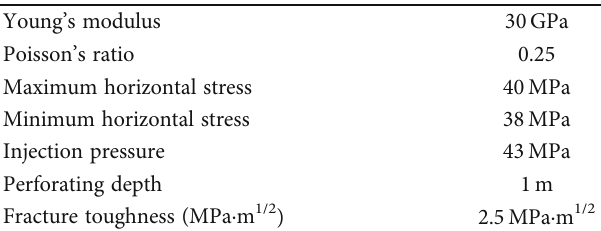
Table 1: Data for